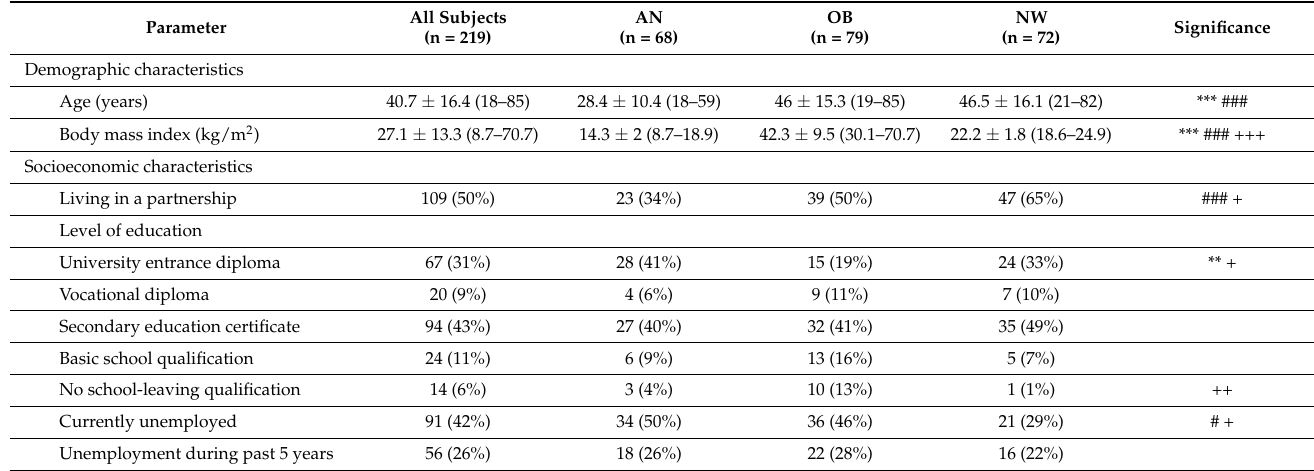
Table 1. Demographic and socioeconomic characteristics, comorbidities, and medication of study